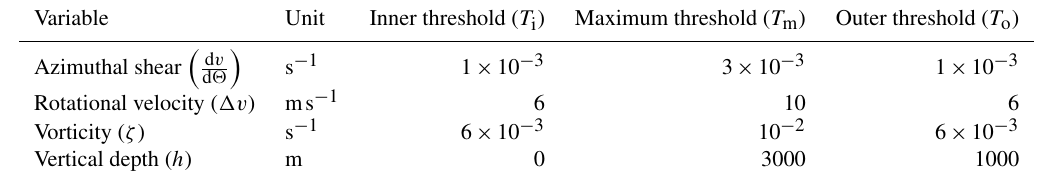
Figure B1. Schematic of mesocyclone detection. (a) Detection of rotation within radar elevations. (b) Vertical merging of detections within thunderstorm contours. Table B1. Mesocyclone detection thresholds following Stumpf et al. (1998) and Hengstebeck et al. (2018). Variable Unit Inner threshold ( T i ) Maximum threshold ( T m ) Outer threshold ( T o